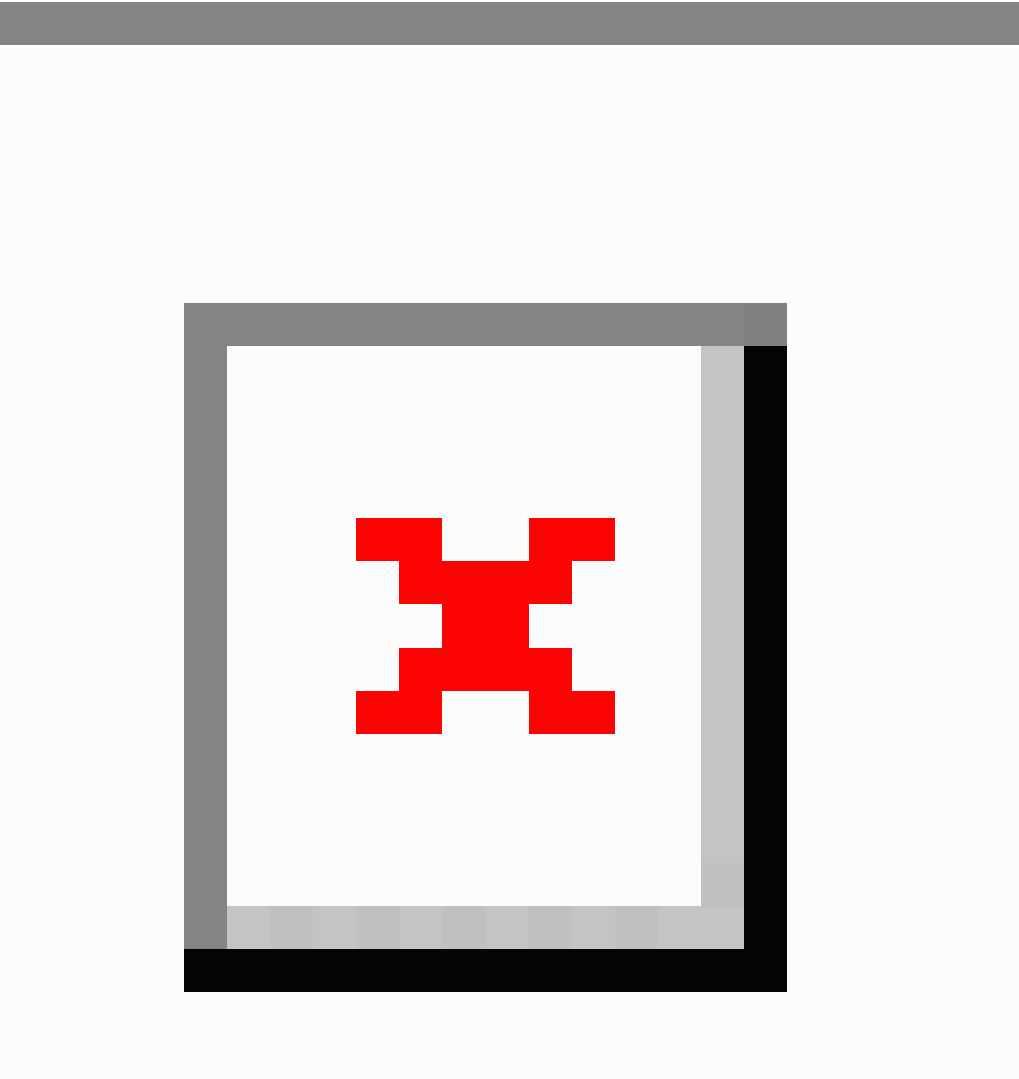
Figure 3. Example of the GeoLocation app used in this study, which relies on cell towers and an Internet connection and provides latitude and longitude in decimal